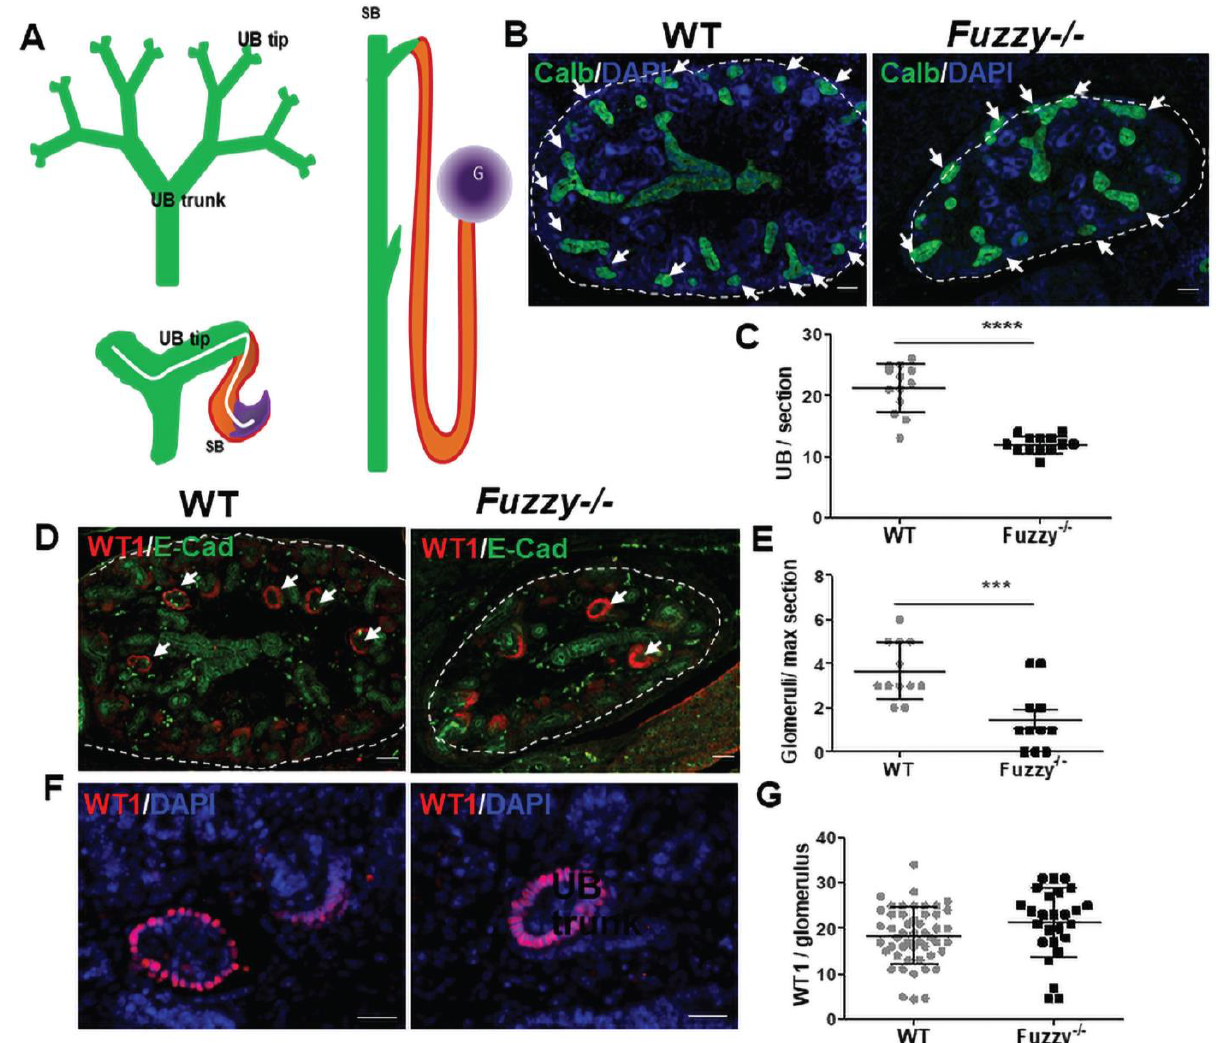
Figure 3. Defective ureteric branching morphogenesis in E14.5 Fuzzy − / − kidneys. ( A ) Schemata of UB branching and of a nephron. ( B ) Wildtype and Fuzzy − / − maximal sections immunostained with anti-Calbindin antibody (green) to visualize UBs and co-stained with DAPI (blue); arrows point at the UB tips, scale bars = 50 µ M. ( C ) Statistical analysis of the number of UB tips per maximal section, WT (total n = 13 sections), Fuzzy − / − (total n = 13 sections) ( D ) Wildtype and Fuzzy − / − kidneys immunostained with anti-WT1 antibody (red) to detect glomerular podocytes and anti-E-Cadherin (green) to visualize UB branches; arrows point at glomeruli, scale bars = 50 µ M. ( E ) Statistical analysis of the number of glomeruli per maximal section, WT (total n = 12 sections), Fuzzy − / − (total n = 11 sections). ( F ) Podocyte are visualized with anti-WT1 antibody (red) and co-stained with DAPI (blue); scale bars = 25 µ M. ( G ) Statistical analysis of WT1+ podocyte per glomerulus, WT (total n = 44 glomeruli), Fuzzy − / − ( n = total 20 glomeruli). For each measurement, maximal sections from 4 embryos per genotype, 2 kidneys per embryo were analyzed. *** p < 0.001, **** p <